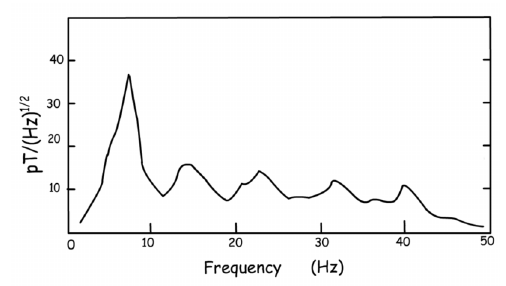
Fig. 3. Schumann resonance